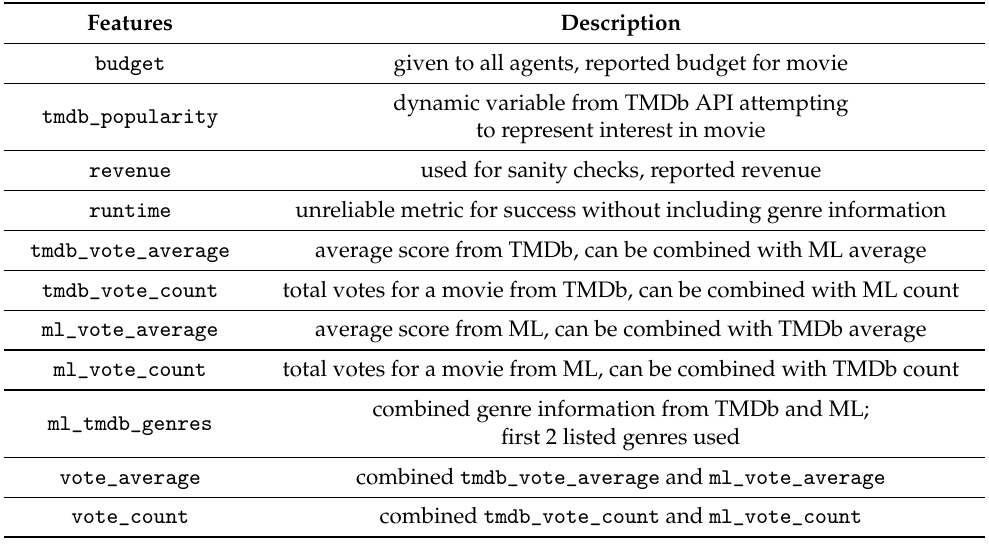
Table 3. Features available for classification.